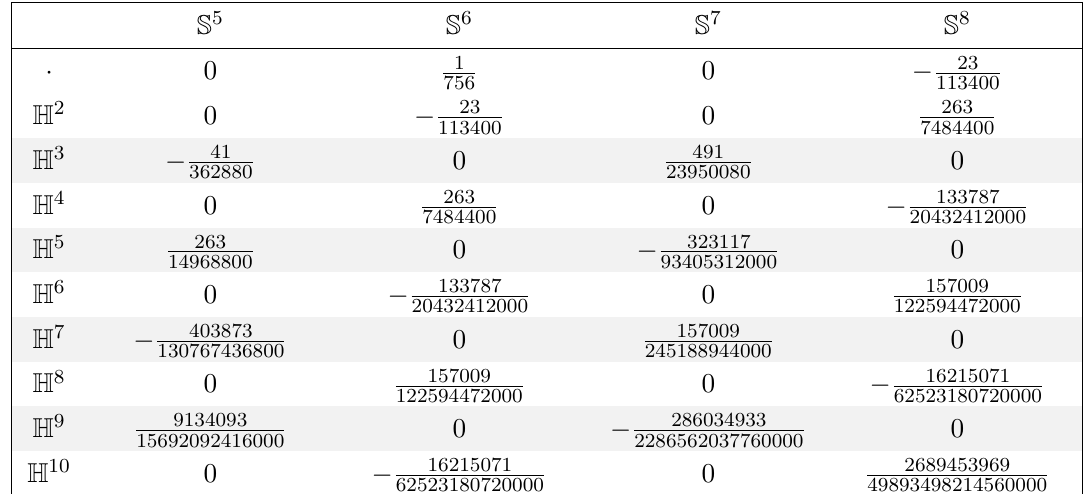
Table 2 . The bulk anomalies A [ H p +1 × S q − 1 ] and the defect anomalies A [ H p +1 × S q − 1 ] (shaded) on H p +1 × S q − 1 with Dirichlet boundary